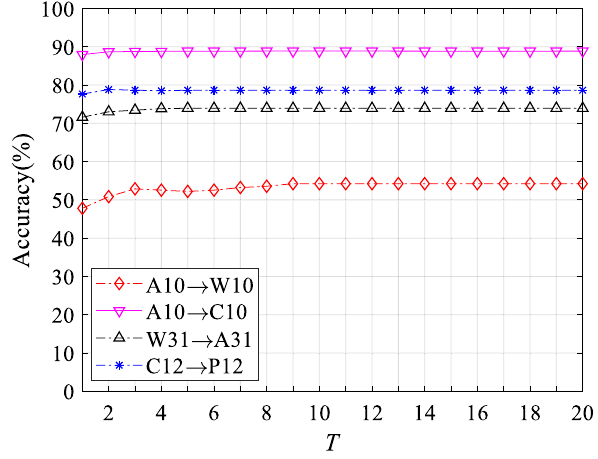
Fig. 7 Convergence of